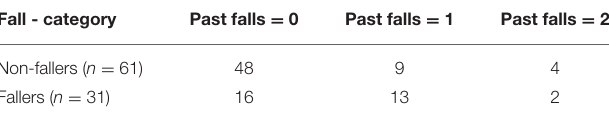
TABLE 3 | Fall history of study